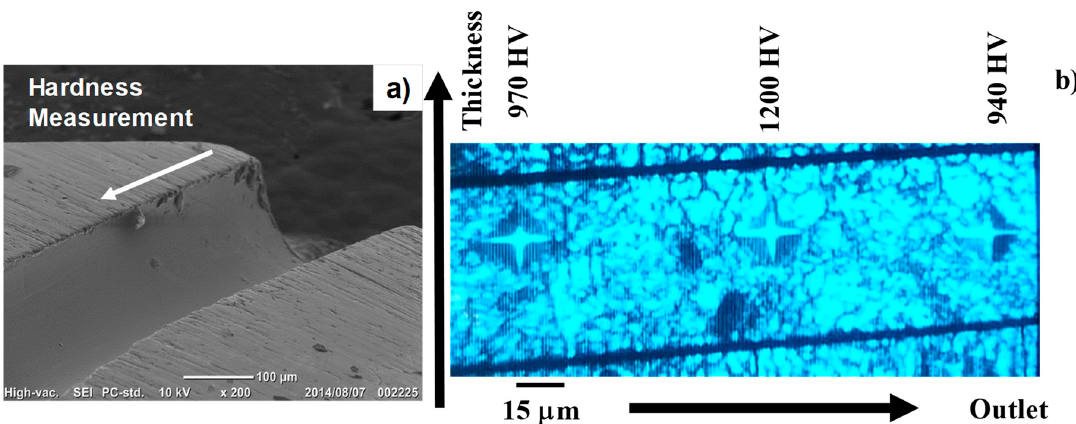
Figure 5. Inner nitriding of the nozzle hole. ( a ) A cross-section of plasma nitrided micro-nozzle with the outlet diameter of 0.2 mm, and, ( b ) micro-hardness distribution near the inner surface of nitrided micro-nozzle at 673 K for 7.2 ks.